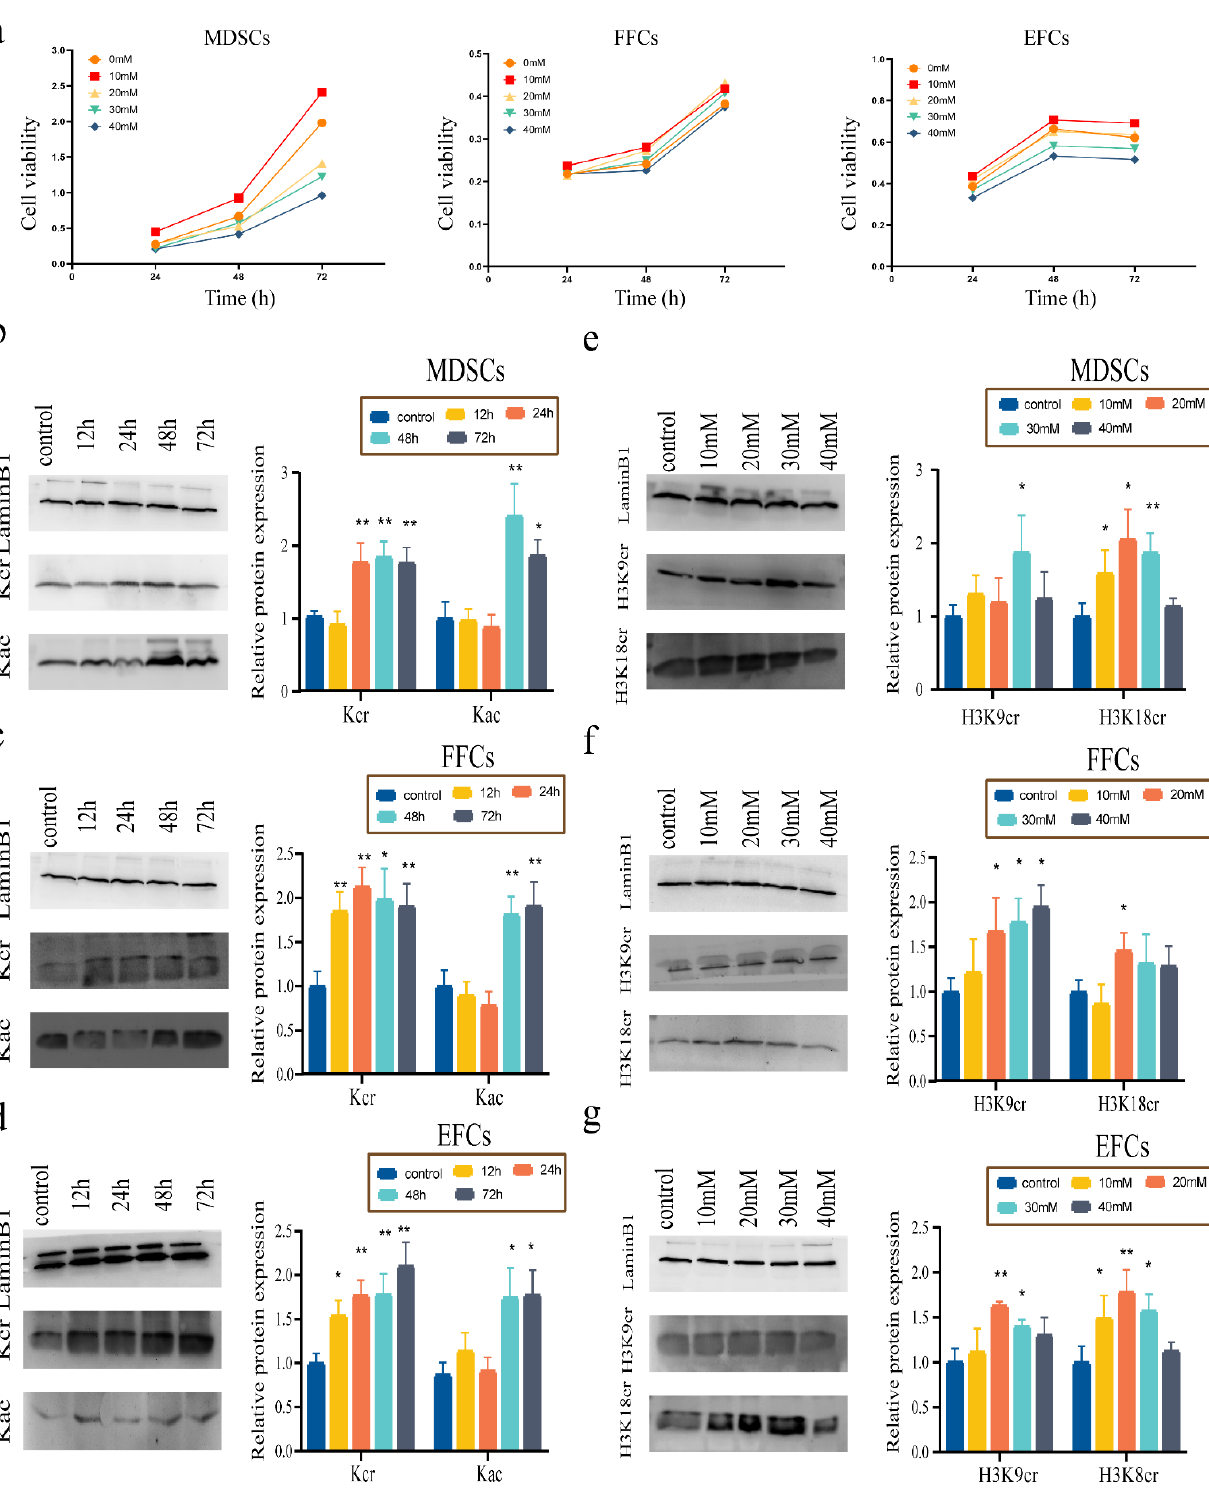
Figure 2. Effect of NaCr on the cell viability and screening the optimal incubation time and concentration. ( a ) Cell viability assessment of treated MDSCs, FFCs, and EFCs with various NaCr concentrations and testing times. ( b – d ) Western blotting and relative quantification of the Kcr and Kac levels in MDSC, FFCs, and EFCs with 10 mM NaCr treatments at various time points. ( e – g ) Western blotting and relative quantification of the H3K9cr and H3K18cr levels in MDSC, FFCs, and EFCs treated with an NaCr concentration gradient for 24 h; * p < 0.05, ** p < 0.01; no asterisk indicates no significant difference; control group: cells that received no treatment.